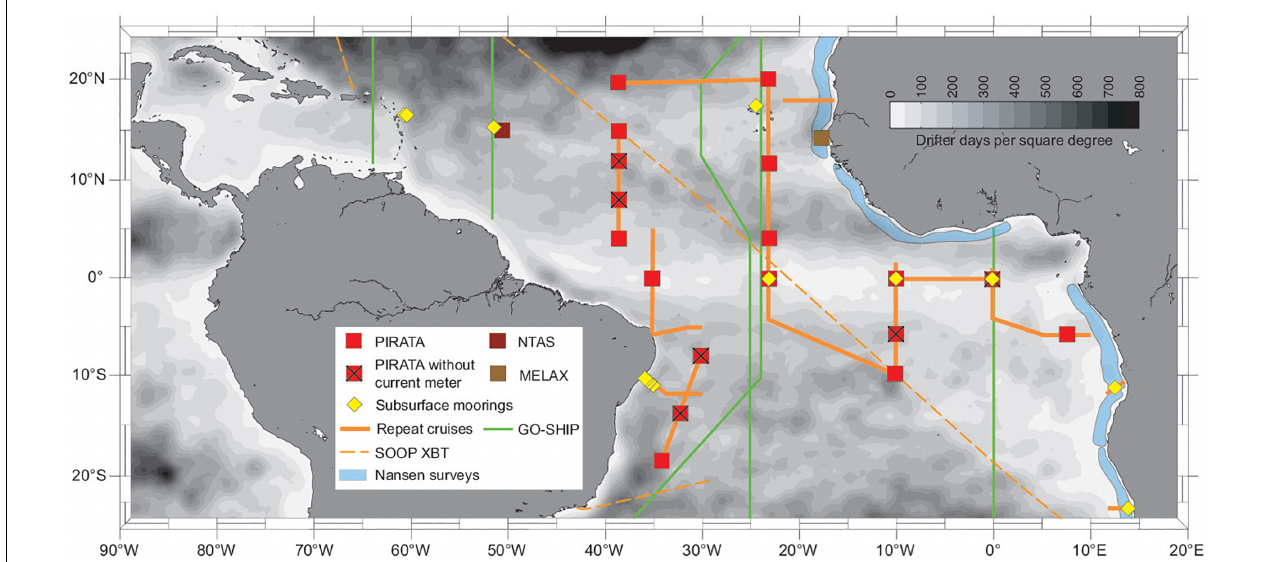
FIGURE 10 | The tropical Atlantic observing system as implemented for the study of ocean circulation and upwelling. Shading indicates total number of days any surface drifter was in each 1 ◦ × 1 ◦ box through February 2018. Surface drifter measurements in the tropical Atlantic began in 1997. Solid orange lines show repeat cruise tracks, mainly for servicing moorings, dashed orange lines show XBT lines, blue shading indicate regions where Nansen surveys (near-coastal physical, chemical, and biological sampling from a research vessel) have been conducted, and green lines show full-depth repeat hydrography cruise tracks (GO-SHIP). The brown square shows the location of the coastal air-sea buoy Melax, yellow diamonds indicate where subsurface velocity and hydrographic moorings have been deployed, and other symbols are as in Figure 6